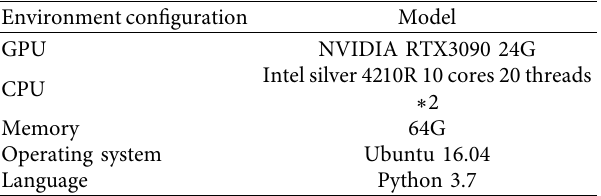
Table 1: Experimental environment